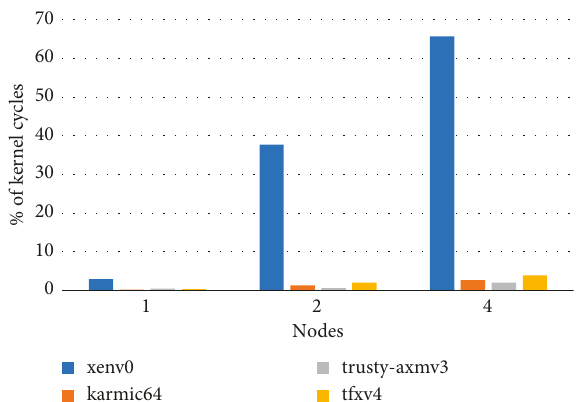
Figure 11: Percentage of kernel cycles (over total number of cycles) in the COTSon framework when using the matrix multiplication benchmark with 512 as the matrix size and 32KiB as the cache size. We varied the number of nodes of the distributed system and the Linux distribution (“xenv0” Ubuntu 16.04, “karmic64” Ubuntu 9.10, “trusty-axmv3” Ubuntu 14.04, and “tfxv4” Ubuntu 10.10). This DSE test permitted to (cid:31) (cid:31) (cid:31) (cid:31) detect a much larger kernel activity of the “xenv0” distribution compared to the other three Linux distributions in both single-node and multiple- node configurations.